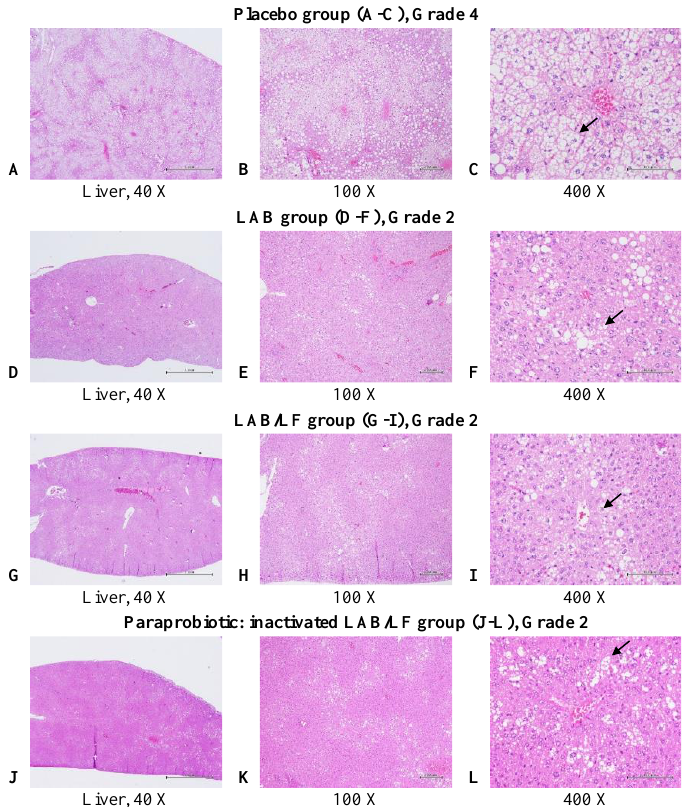
Figure 3. Representative images of histopathological examinations of the liver in DIO mice treated with a placebo or one of three probiotic mixtures. The groups are defined and explained in the legend of Table 1. Livers showed multifocal and severe fatty changes in the microvesicles and macrovesicles (arrow), which were graded severe/high in the placebo (( A – C ), Mouse A2), and moderate in the LAB (( D – F ), Mouse B5), LAB-LF (( G – I ), Mouse C6), and inactivated LAB/LF (( J – L ), Mouse D3) groups. Liver sections were stained with H&E; images at 40×, 100×, and 400× magnification are shown. Grade 4 fatty infiltration was observed in most mice in the placebo control group, while Grade 2 fatty infiltration was often observed in the mice fed with the LAB, LAB/LF, or inactivated LAB/LF supplements.